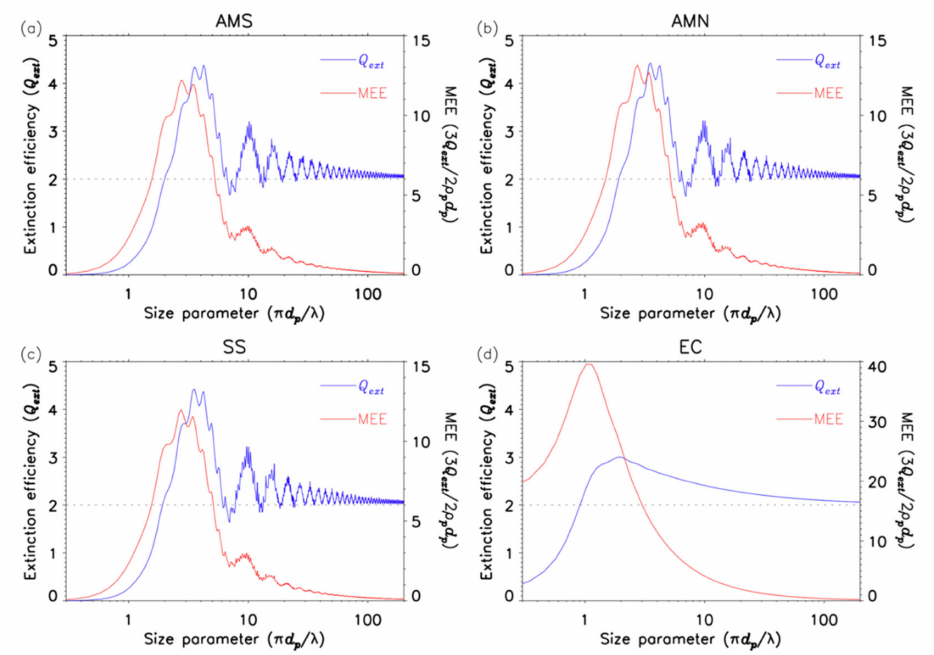
Figure 1. The calculated extinction e ffi ciency ( Q ext , blue) and mass extinction e ffi ciency (MEE, red) as a function of size parameter ( π d p / λ ) for ( a ) ammonium sulfate (AMS), ( b ) ammonium nitrate (AMN), ( c ) sea salt (SS, NaCl), and ( d ) elemental carbon (EC). Mie code [3] was used for these calculations at a wavelength λ = 550 nm, and the corresponding refractive indices and density of aerosols are shown